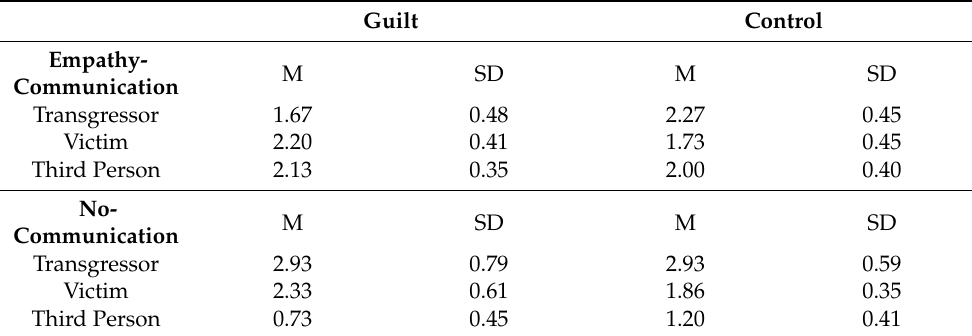
Table 2. Means and standard deviations of the lottery tickets distribution among the three individuals in each condition of Experiment 2. Guilt